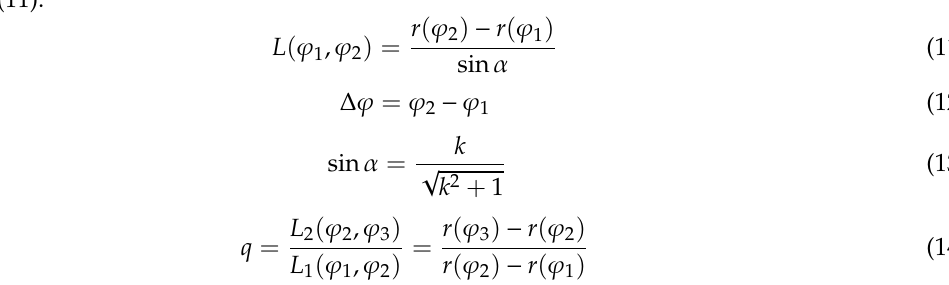
= 27.5 ◦ and α = 45 ◦ 1